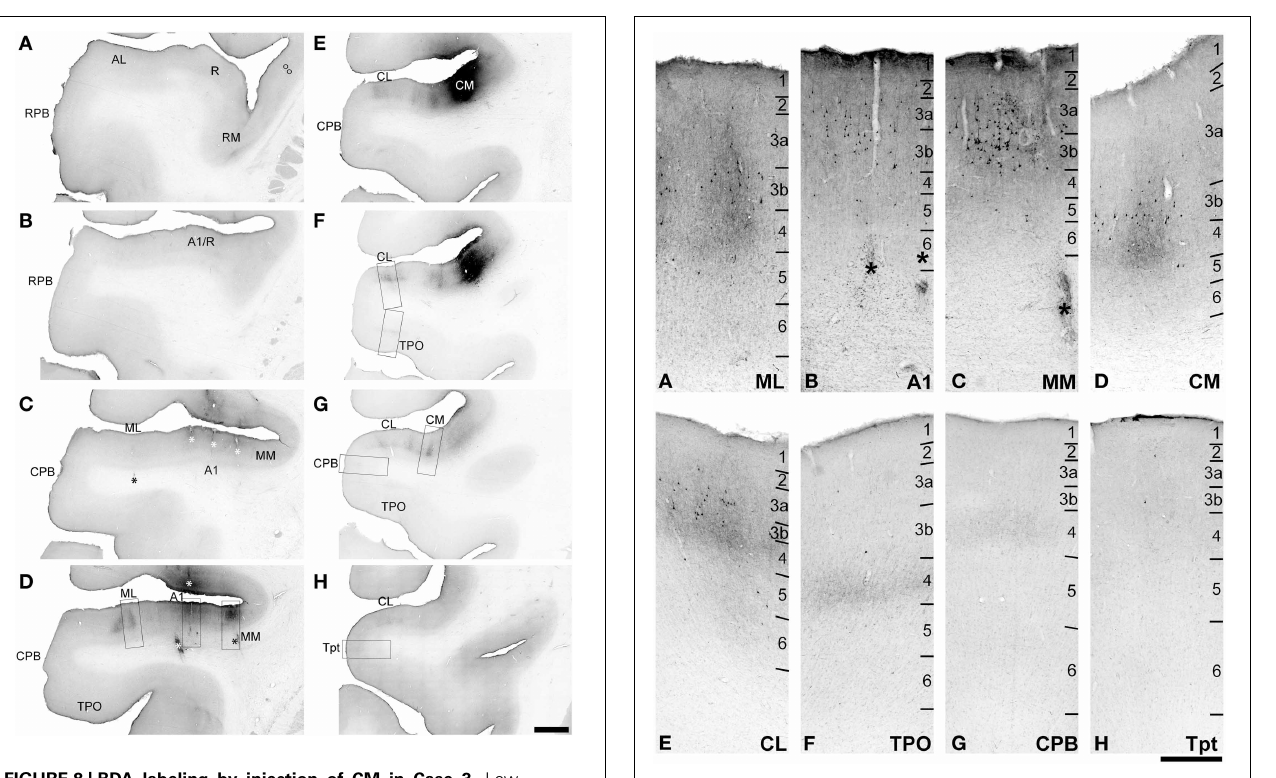
FIGURE 9 | BDA labeling of areas corresponding to rectangular selections (A–H) from (D–H) in Figure 8. Asterisks in (B,C) denote locations of electrolytic lesions. See text for detailed descriptions and Figure 10 for graphical summary of these data. Scale, 500 µ